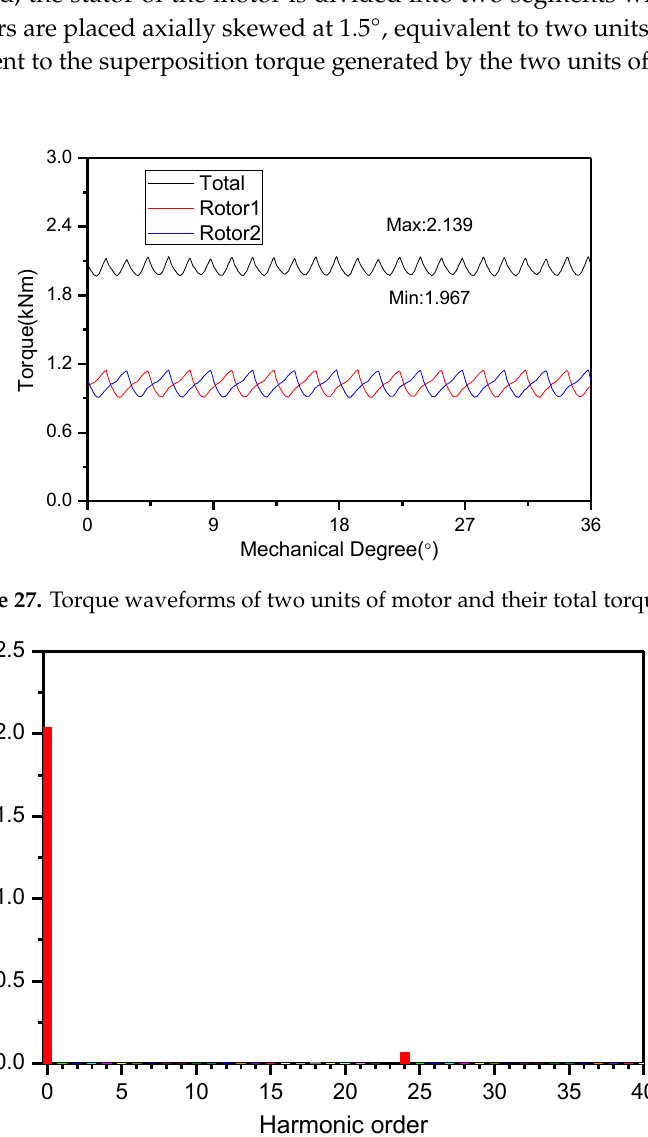
Figure 26. Diagram of the outer rotor.